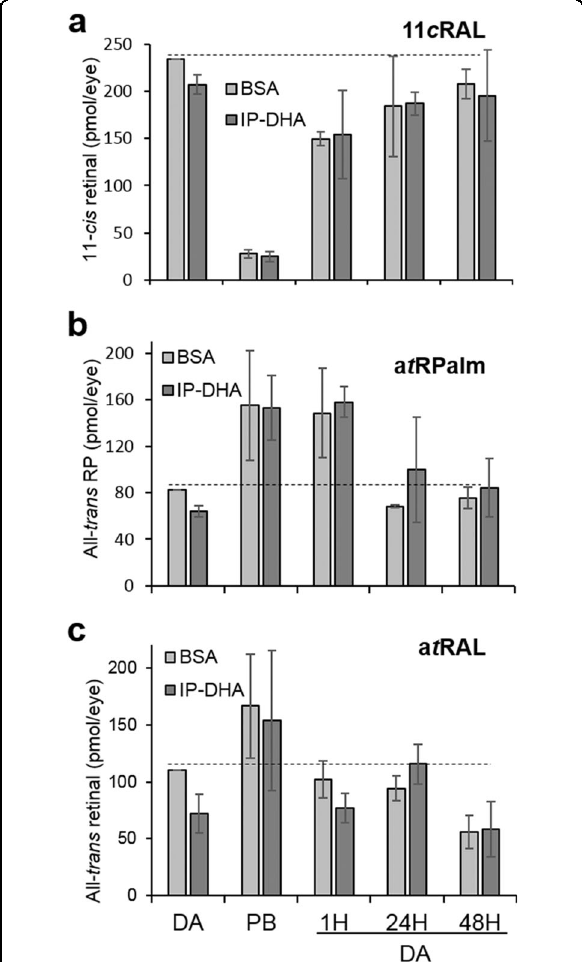
Fig. 6 Regeneration kinetics after short light exposure. Regeneration kinetics of 11 c RAL a , a t RPalm b , and a t RAL c were examined after ~90% rhodopsin bleaching by illumination at 24 mW/ cm 2 for 2 min. Abca 4 − / − mice kept in the dark for 24 h (DA) were administered BSA or BSA + IP-DHA (25 mg/kg) in the tail vein 5 min before the 2-min light exposure. Prior to (DA) or after bleaching (PB), the mice were returned to the dark for the indicated time (DA 1H, 24H, and 48H), and retinoid quanti fi cation was subsequently performed by normal-phase HPLC. Error bars represent the SD, n =